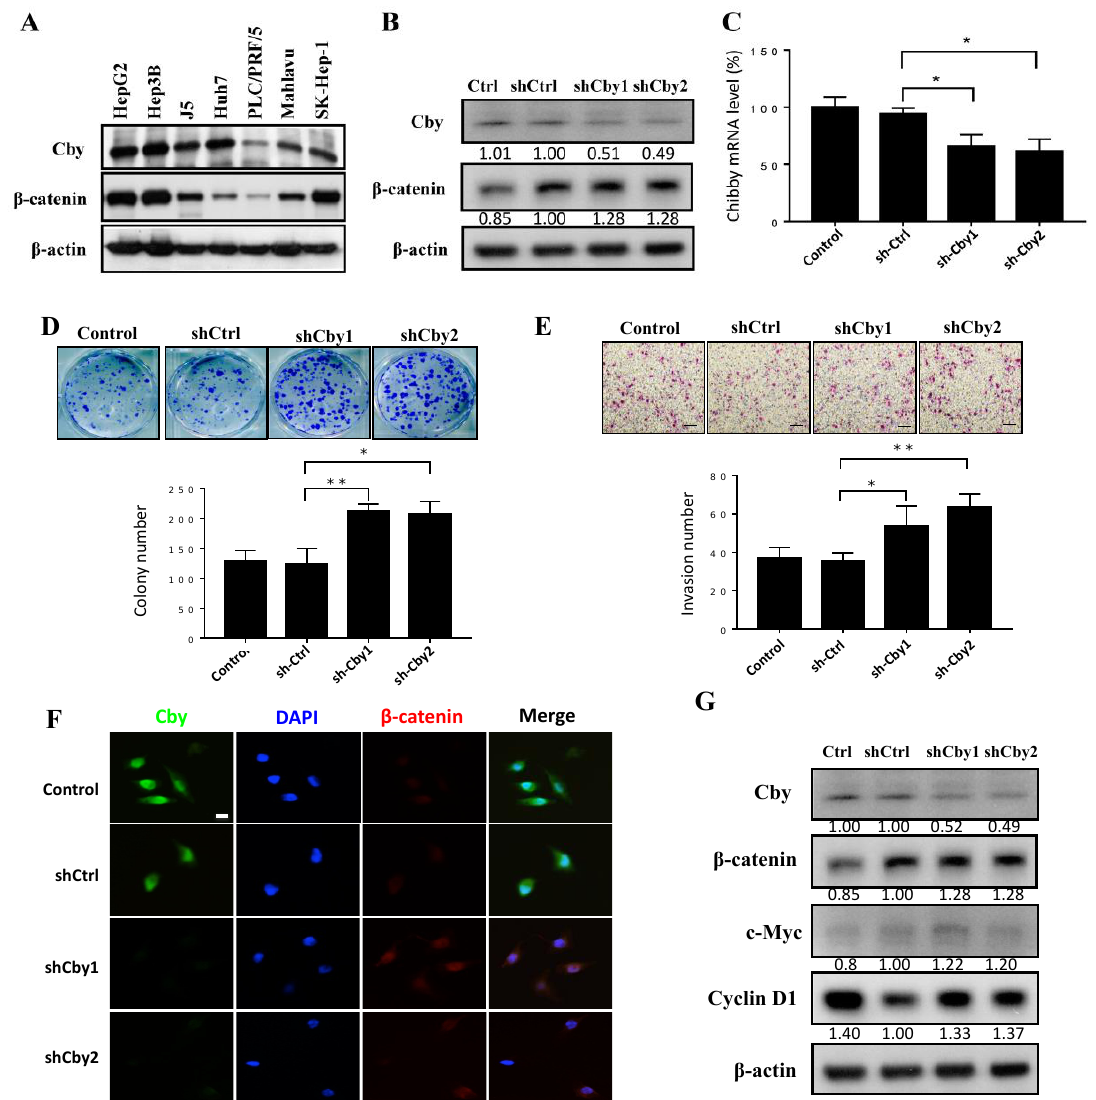
Figure 4. Knockdown of Chibby expression increases cell proliferation and invasion of HCC cells. Figure 4. ( A ) Western blot analysis of Chibby protein in a variety of HCC cell lines. Two plasmids expressing Chibby -specific shRNA sequences were transfected into Huh7 cells, and the plasmid sh-control was designed as a scramble control. The protein level of Chibby was analyzed by Western blot ( B ), and the RNA level was detected by qRT-PCR ( C ). The Huh7 cells transfected with shChibby promoted cell proliferation and invasiveness by colon-formation assay ( D ) and Boyden chamber system ( E ). ( F ) Immunofluorescence was used to detect the upregulation of β -catenin in Huh7 cells after transfection with shChibby. In cells treated with shChibby, prominent β -catenin staining was detected. ( G ) Chibby knockdown activates the Wnt / β -catenin pathway in Huh7 cells. Analysis of β -catenin, C-Myc, and cyclin D1 expression by Western blot in Huh 7 cells treated with shChibby. β -actin was used as the loading control. Data represent mean ± SE from three independent analyses. Scale bar, 100 µ m, * p < 0.05 and ** p < 0.01 vs.